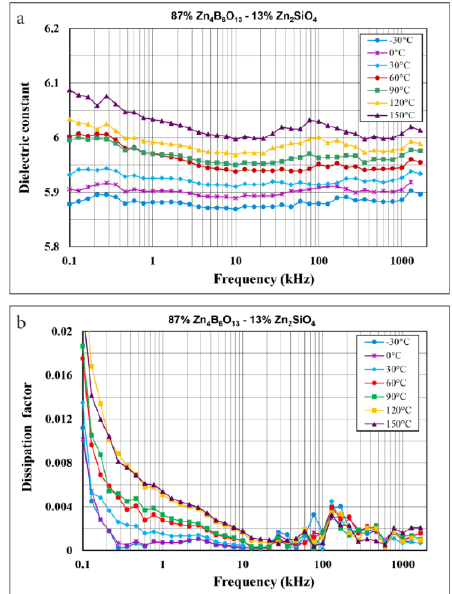
Figure 8. Dielectric constant ( a ) and dissipation factor ( b ) as a function of frequency in the range 100 Hz to 2 MHz and in the temperature range –30 to 150 °C for 87% Zn 4 B 6 O 13 –13% Zn 2 SiO 4 sintered at 930 °C.